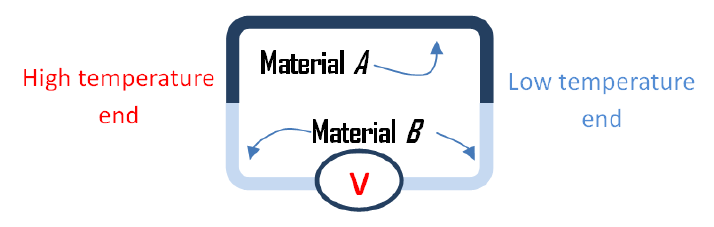
Figure 11. The Seebeck effect: a voltage generated by the temperature difference across the junctions